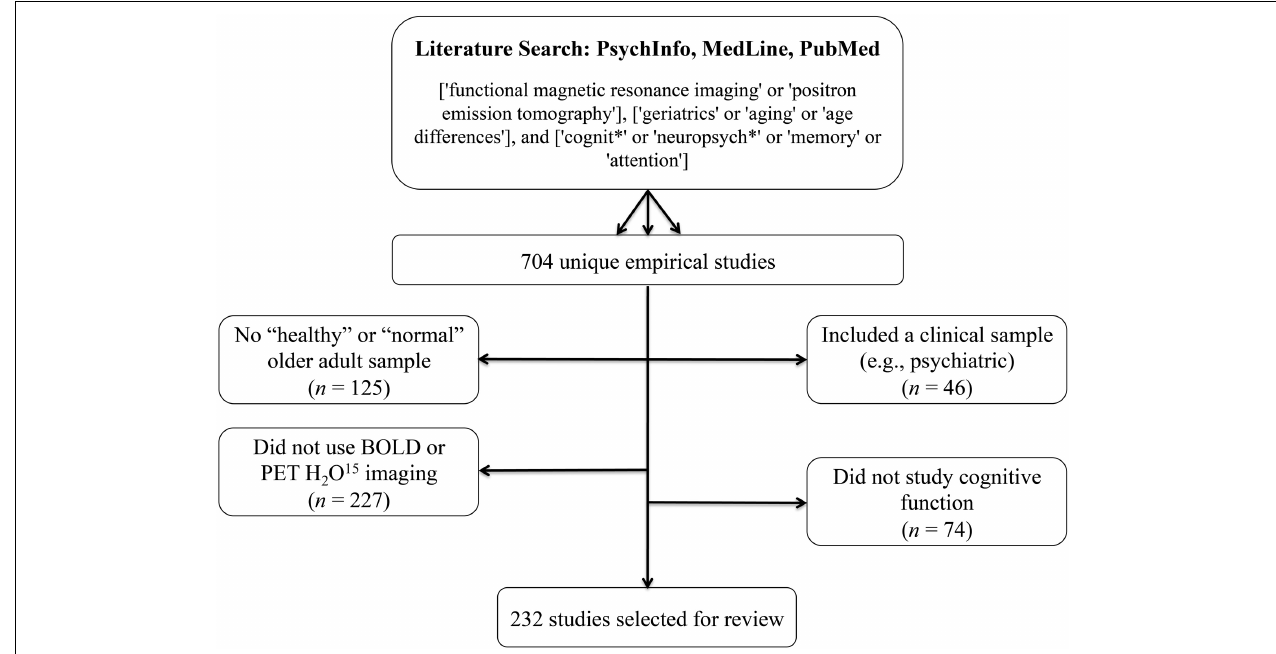
FIGURE 1 | Literature search terms and exclusion criteria. Based on these criteria, 232 studies were selected for